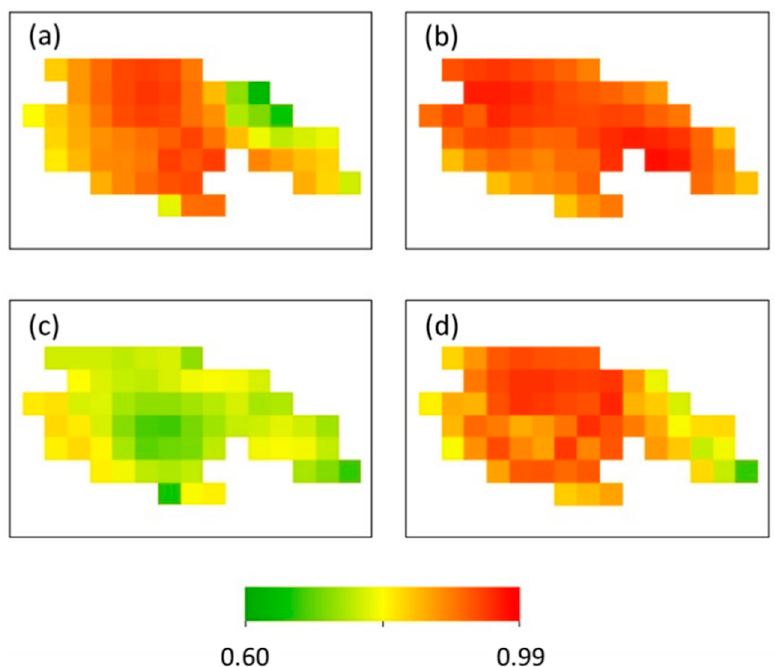
Figure 6. Pearson correlation between target dataset and simulated dataset: ( a ) Spring, ( b ) summer, ( c ) autumn, and ( d ) winter.